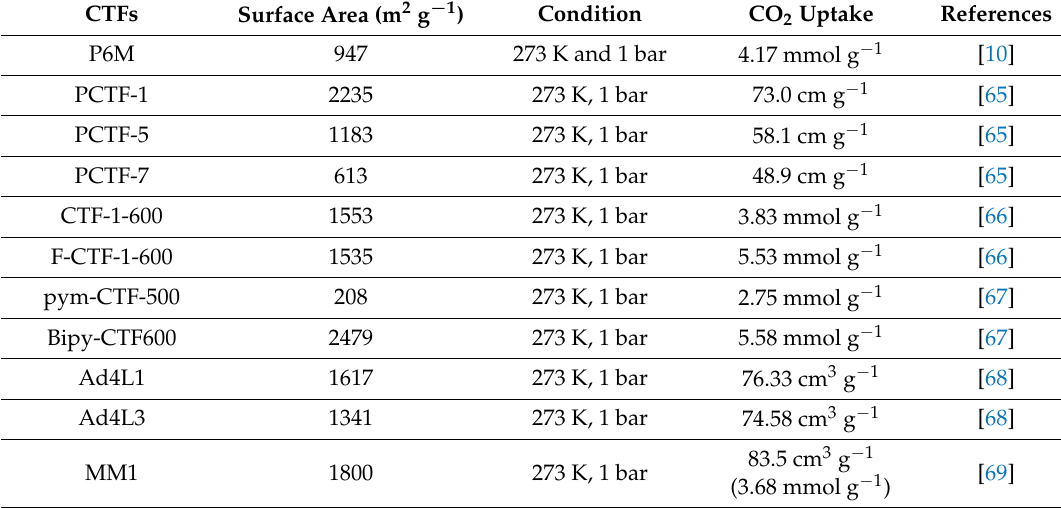
Table 2. Summary of the results of the CO 2 uptake reported in the literatures showing the recent progress in the field. Acac-CTF: acetylacetone